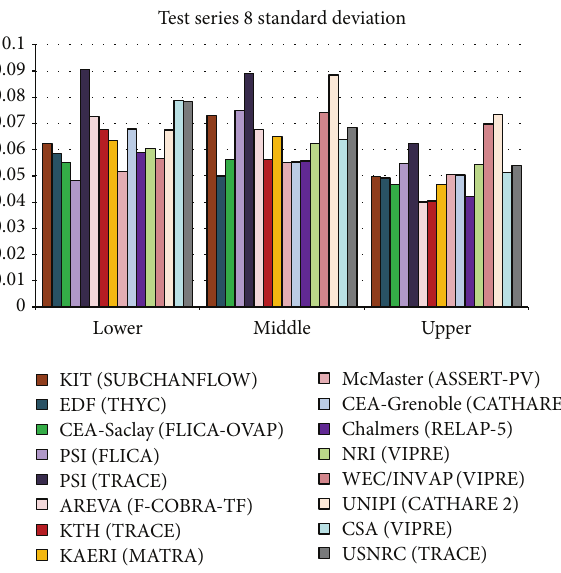
Figure 28: Test series 7 void fraction standard deviation.